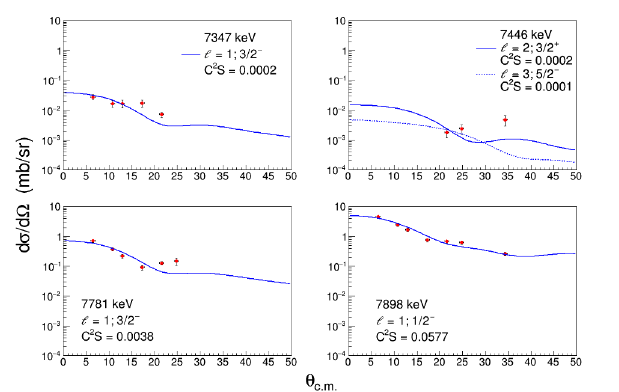
Figure 2. (Color online) Angular distributions of 31 P levels that dominate the thermonuclear reaction rate in the 30 Si( p , γ ) 31 P reaction. Blue curves are finite-range DWBA calculations normalized to experimental data points in